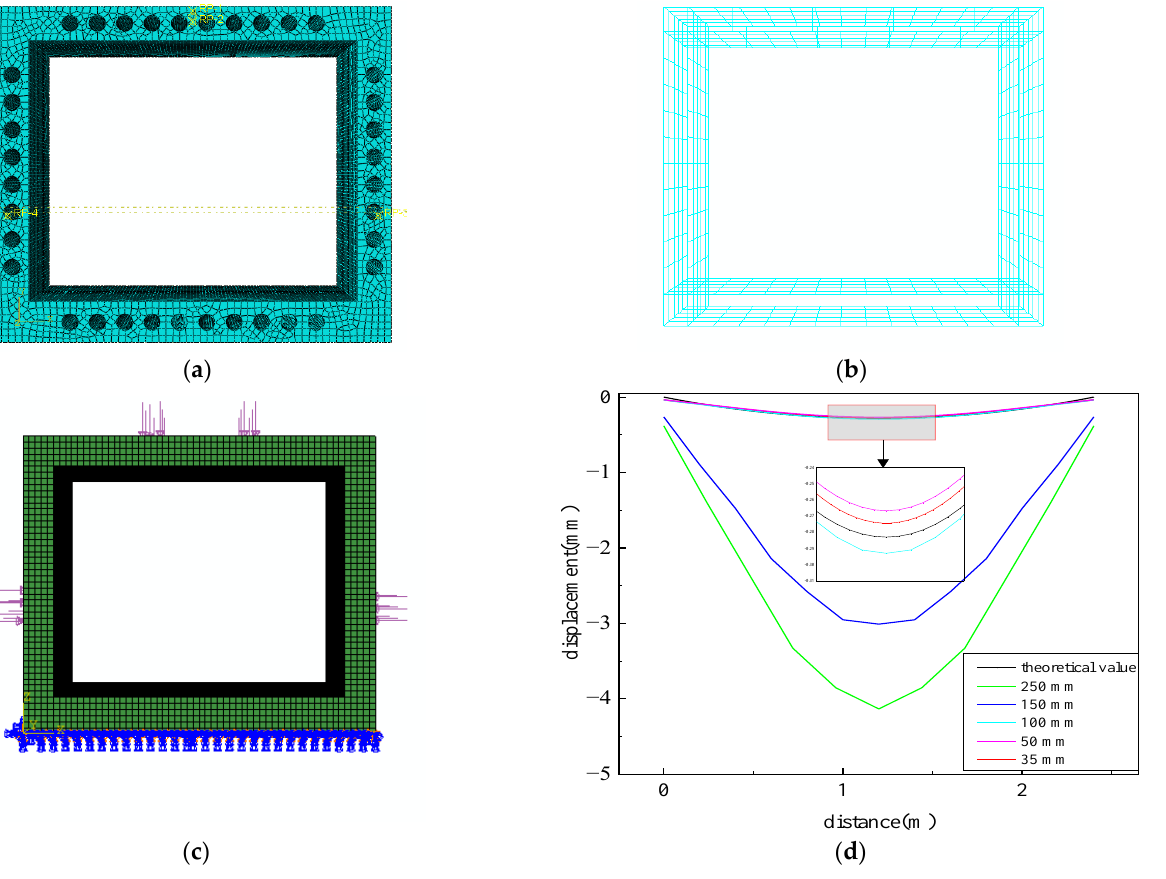
Figure 5. Mesh and Boundary Condition. ( a ) Hollow specimen mesh. ( b ) Reinforcement mesh. ( c ) Boundary condition of point load. ( d ) Sensitivity of mesh size.